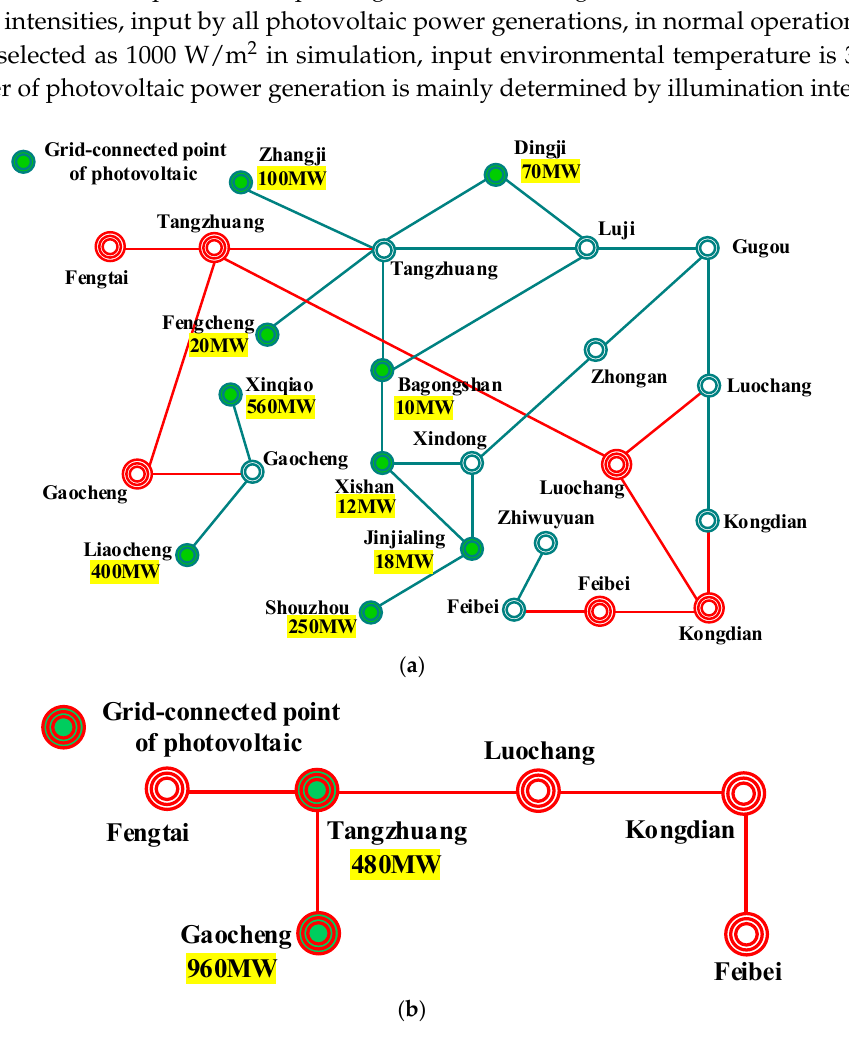
Figure 12. Single line diagram of Huainan 500 kV power grid. ( a ) overall structure; ( b ) simplified structure.